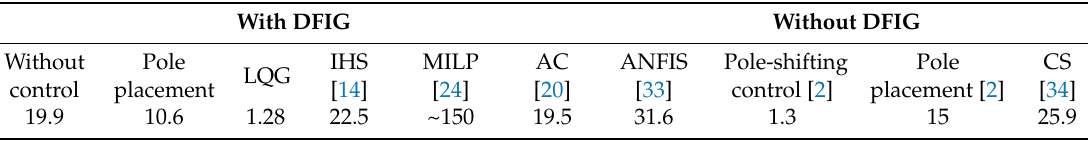
Table 1. Settling time of interconnected power systems at normal load (s).